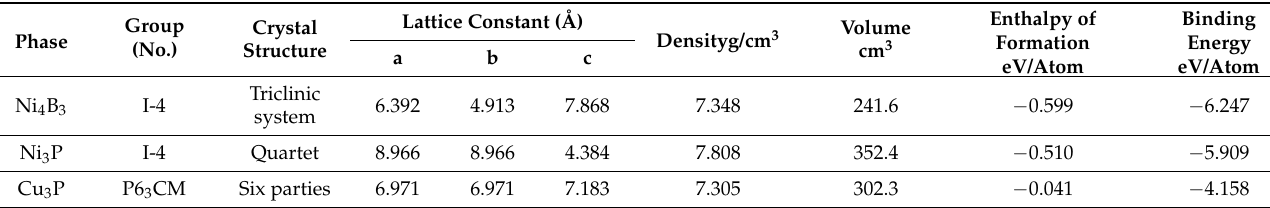
Figure 10. Crystal structure of Ni 4 B 3 phases. Table 2. Crystal structure parameters of Ni 4 B 3